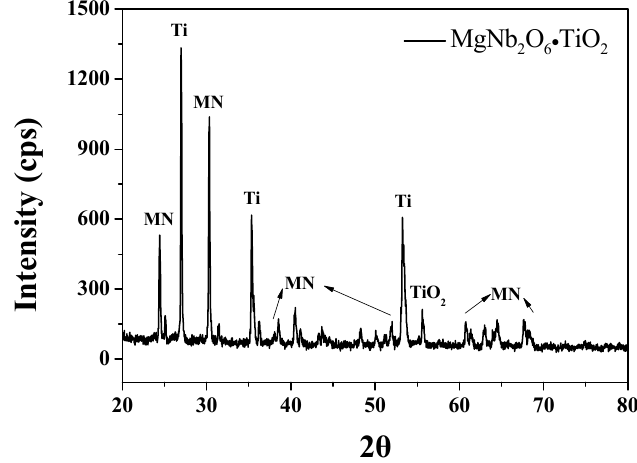
Figure 1. X-ray diffraction patterns for the MgNb 2 O 6 ·TiO 2 powders.